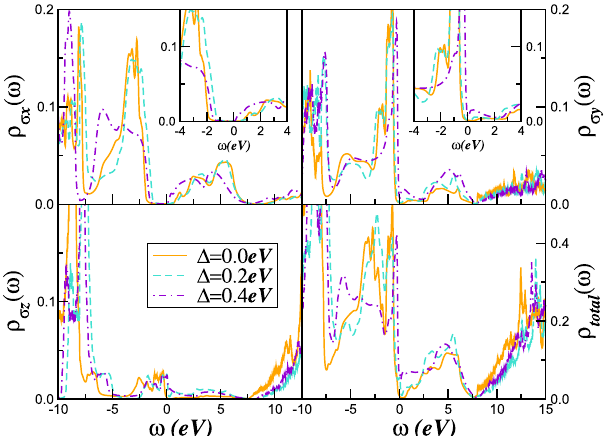
Figure 4. Orbital-selective insulator-to-metal transition in pressurized O 2 . In our theory, we vary the trial orbital-splitting Δ within LDA + DMFT to simulate structural changes upon pressure. In our results for the orbital-selective metallic phase the p y (and hence, total) DOS shows a clear pseudogap around E F , corresponding to an orbital-selective, non-Fermi liquid metallic phase. Inset at the top panels show the evolution of the electronic states close to the Fermi energy.